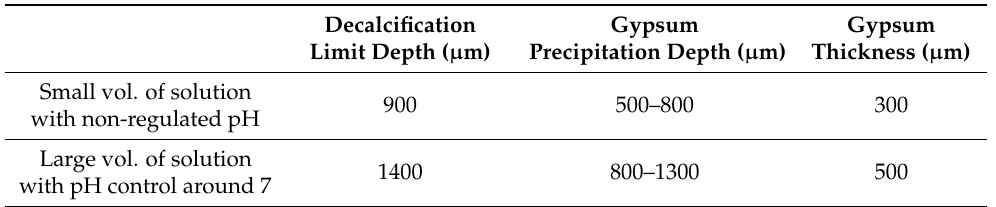
Table 5. Experimental depths of decalcification and gypsum precipitation when the samples are immersed in a small volume of solution without regulation of pH and when the samples are degraded in a large volume of solution under controlled